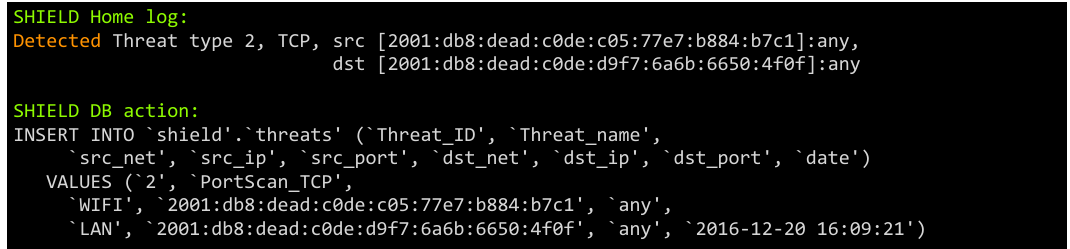
Figure 7. Detection of a port scan from an host in the Wi-Fi